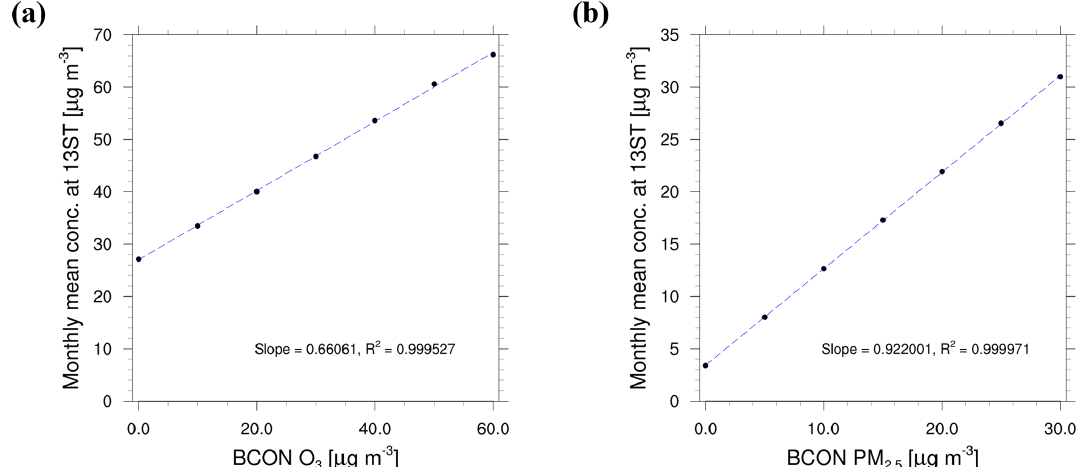
Figure D1. Test of the boundary conditions for lateral entrainment into the model domain of Hamburg. Relationship between the monthly mean concentration (July 2012) in the grid cell in which station 13ST is located and the BCON offset added to the CMAQ concentrations at the lateral boundaries: (a) O 3 and (b) PM 2 . 5 . Zero BCON offset corresponds to the original boundary conditions from CMAQ.